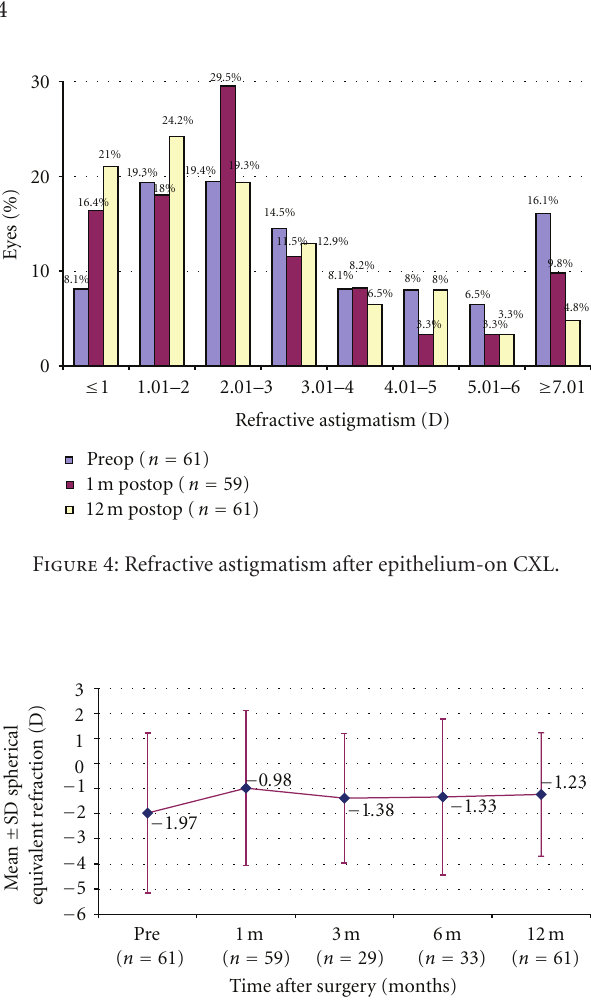
(less myopic, P = 0 . 05), while mean cylinder decreased by 1.15 D ( P = 0 .